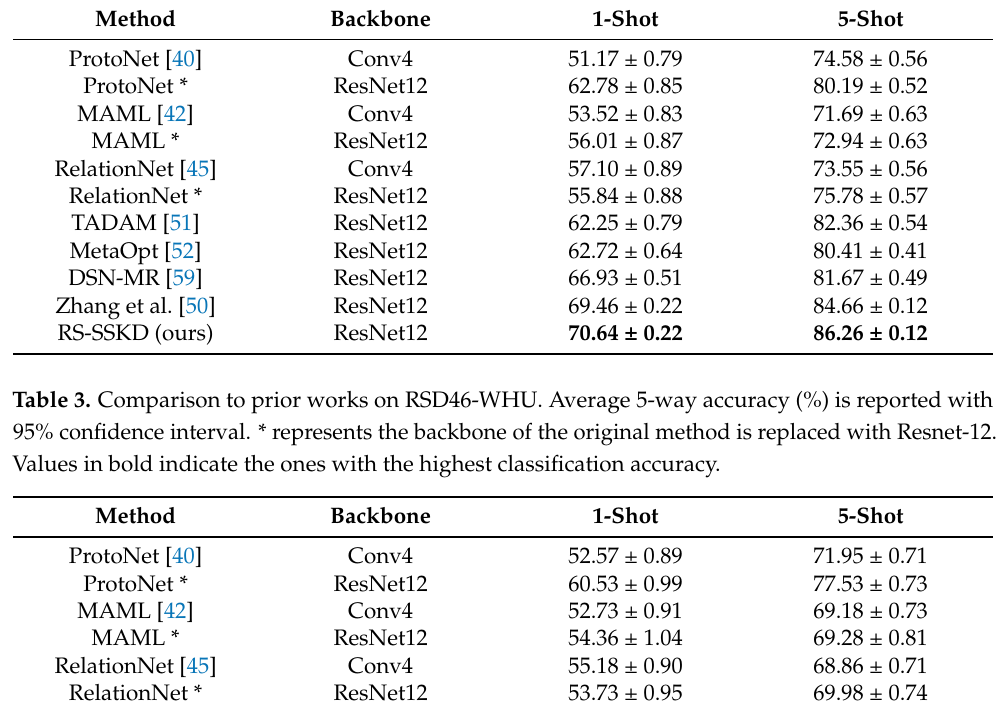
Table 2. Comparison to prior works on NWPU-RESISC45. Average 5-way accuracy (%) is reported with a 95% confidence interval. * represents the backbone of the original method is replaced with Resnet-12. Values in bold indicate the ones with the highest classification accuracy.